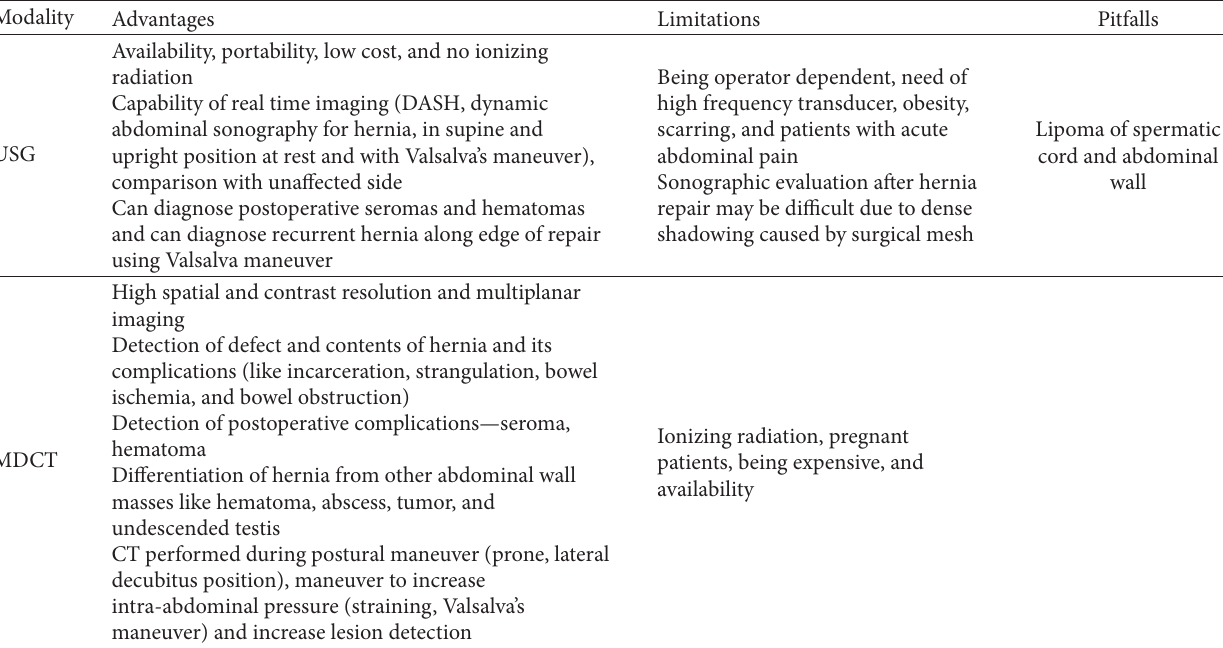
Table 2: Advantages, limitations, and pitfalls of diagnostic modalities for abdominal wall